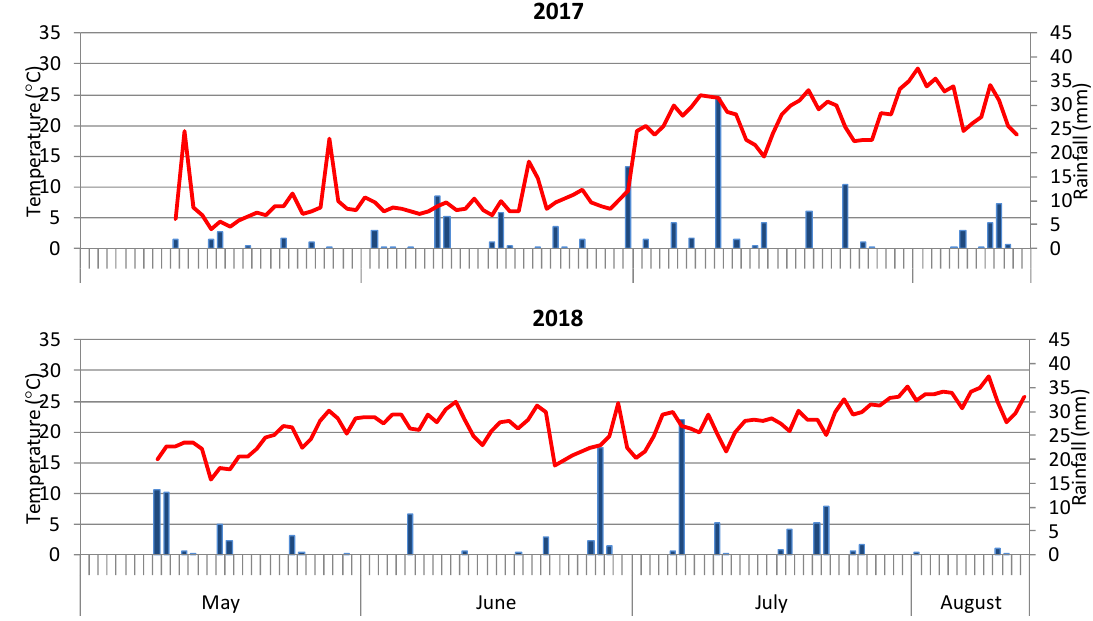
Figure 1. Mean daily temperature and rainfall during the vegetation period of onion in the experimental years 2016, 2017, and 2018.